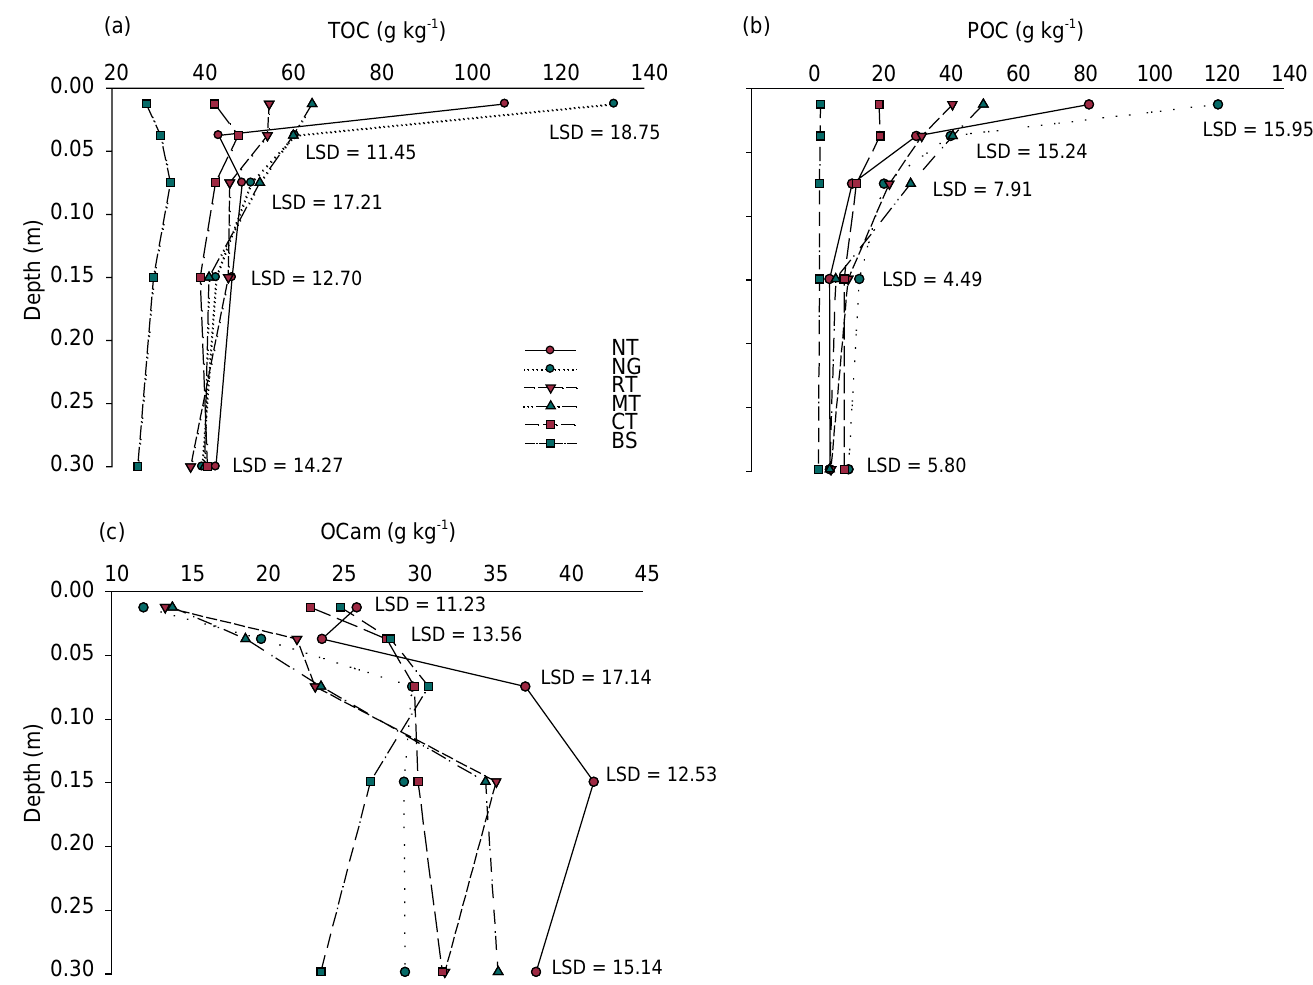
Figure 1. Contents of total organic carbon (a), particulate organic carbon (b), and organic carbon associated with minerals (c) in an Inceptisol after 27 years under various soil tillage methods: no-tillage (NT), rotating tillage (RT), minimum tillage (MT), conventional tillage (CT), bare soil (BS), and natural grassland (NG) as a reference, in the 0.000-0.025, 0.025-0.050, 0.050-0.100, 0.100-0.200, and 0.200-0.400 m soil layers. LSD = least significant difference between treatment means in the treatments comparing all depths evaluated; TOC = total organic carbon; POC = particulate organic carbon; OCam = organic carbon associated with